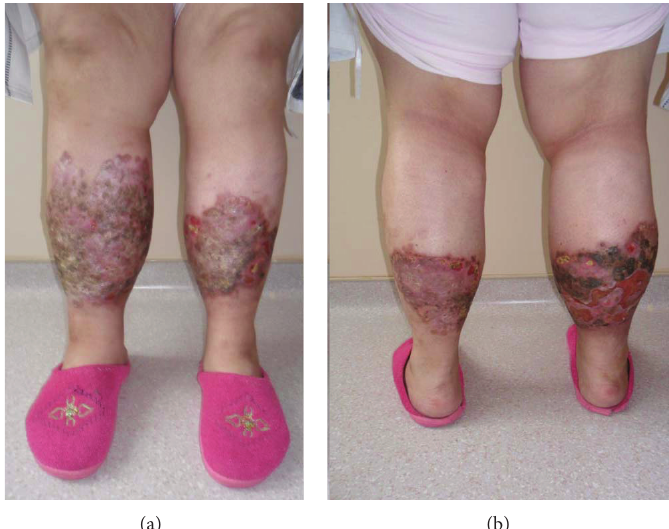
Figure 1: Bilateral ulcerated, oozing, and persistent plaques with depressed central areas and elevated peripheral rings over legs.